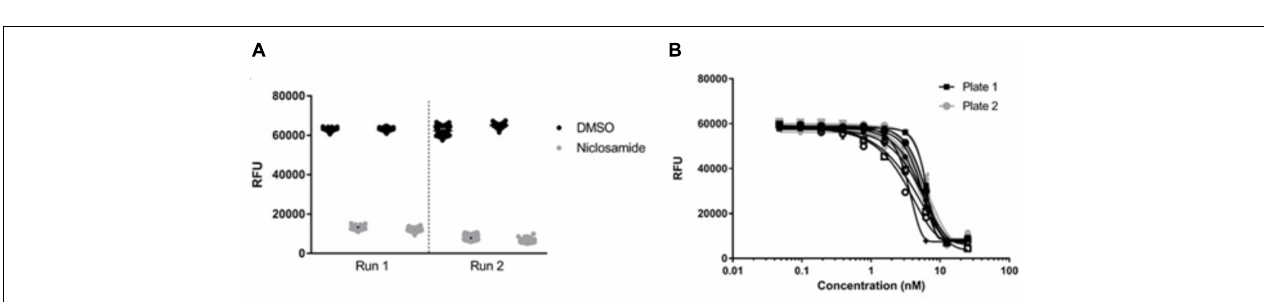
FIGURE 4 | Metabolic activity correlates with bactericidal activity. Nutrient-starved bacteria were exposed to compounds for 24–72 h, alamarBlue R (cid:13) was added and RFU measured after 24 h. Aliquots from the same samples were used to determine: (A) Bacterial viability (CFU; data are the average ± SD of 2 biological replicates); (B) metabolic activity.